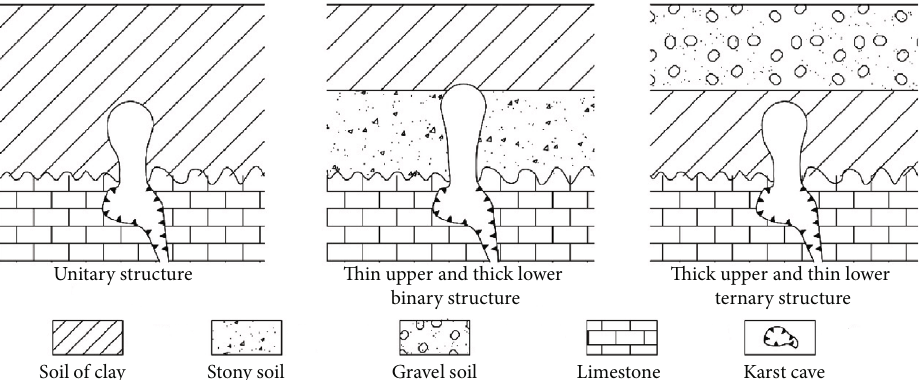
Figure 2: Structure types of overlying soil